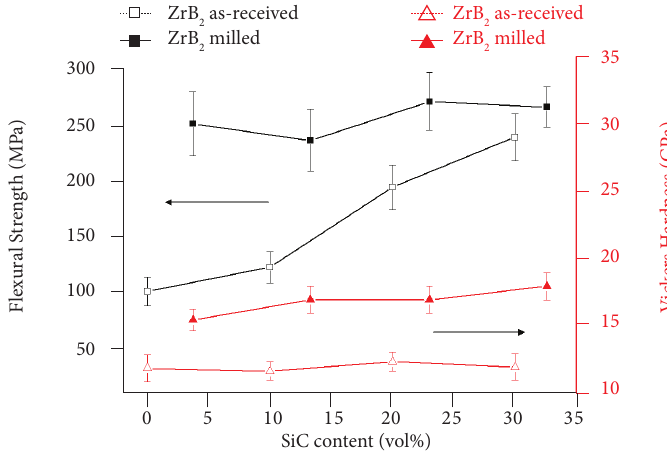
Figure 8. Flexural strength and micro hardness as a function of SiC content of ZrB processed with AZ and MZ powder sintered at 2050 °C/1h.